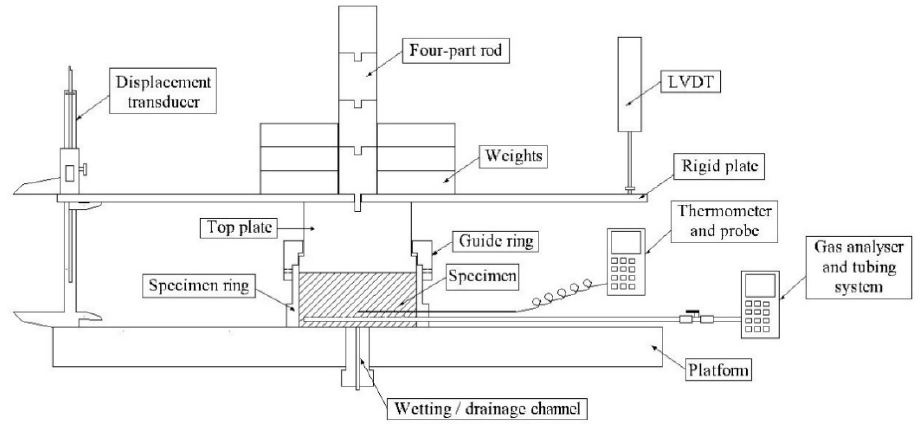
Figure 2. Used oedometer device.